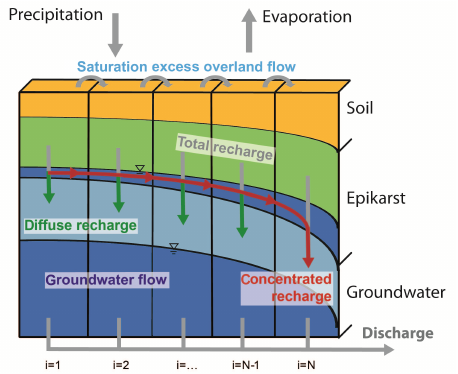
Figure 2. The VarKarst model structure. applied to a set of N = 15 model compartments (Fig.